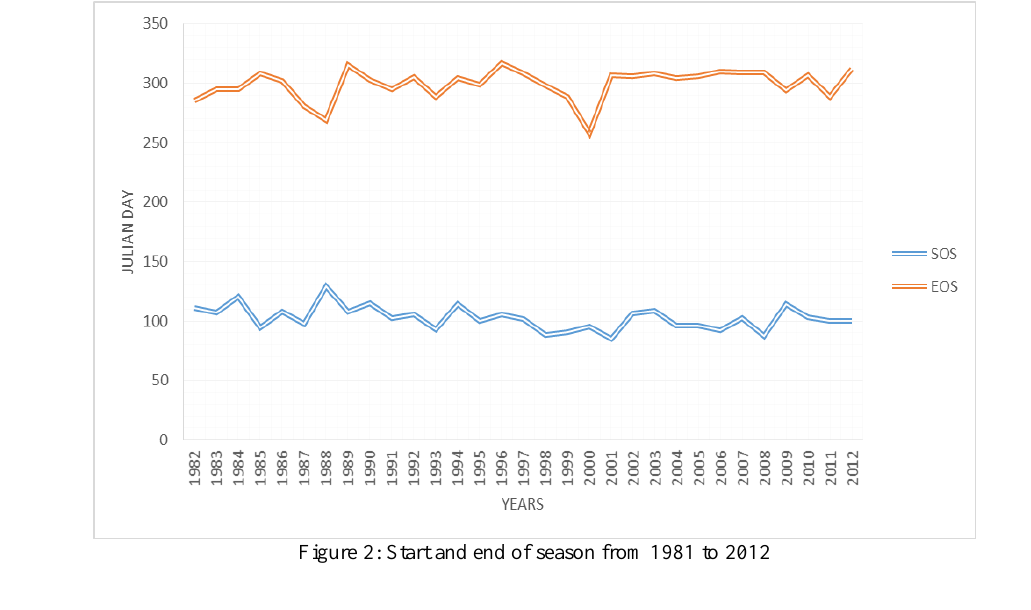
Figure 2: Start and end of season from 1981 to 2012